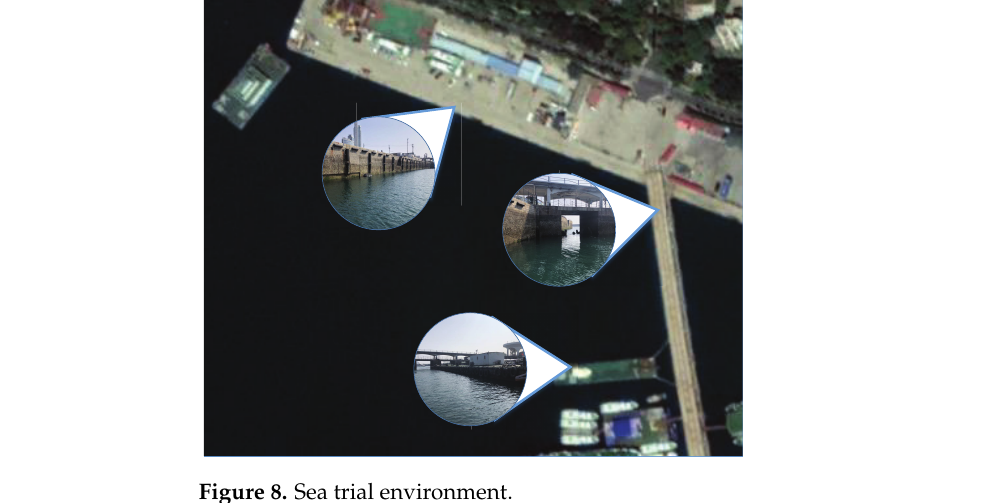
Figure 8. Sea trial environment.